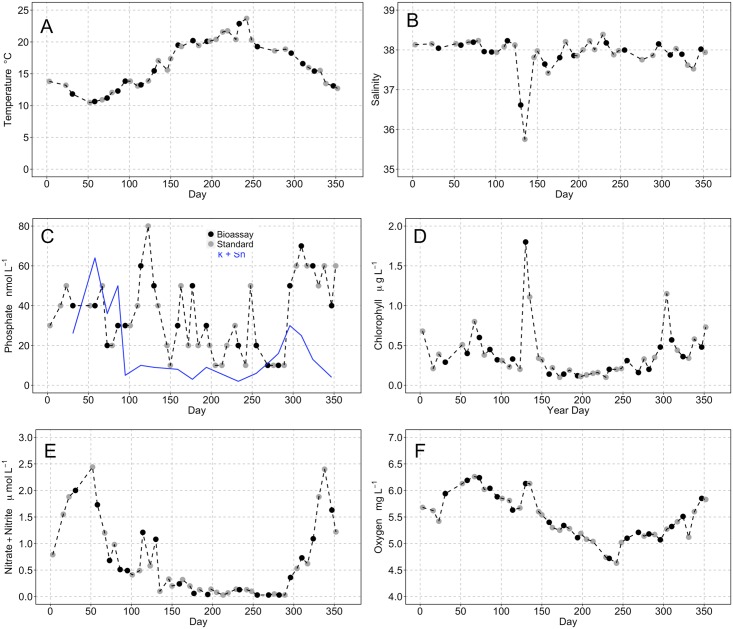
Time series observations of environmental parameters.Time series data of environmental parameters monitored in parallel to bioassay experiments during 2012 for (A) temperature, (B) salinity, (C) inorganic phosphate (PO43-), (D) chlorophyll, (E) dissolved inorganic nitrogen (DIN = NO32- + NO2-) and (F) dissolved oxygen. In panel (C) the dashed line is soluble reactive phosphorous (SRP) determined analytically and the solid blue line is an estimate of biologically available phosphate (k + Sn). Grey symbols mark the sampling dates when standard environmental parameters were measured and black symbols mark those where the kinetic bioassay experiments were conducted.